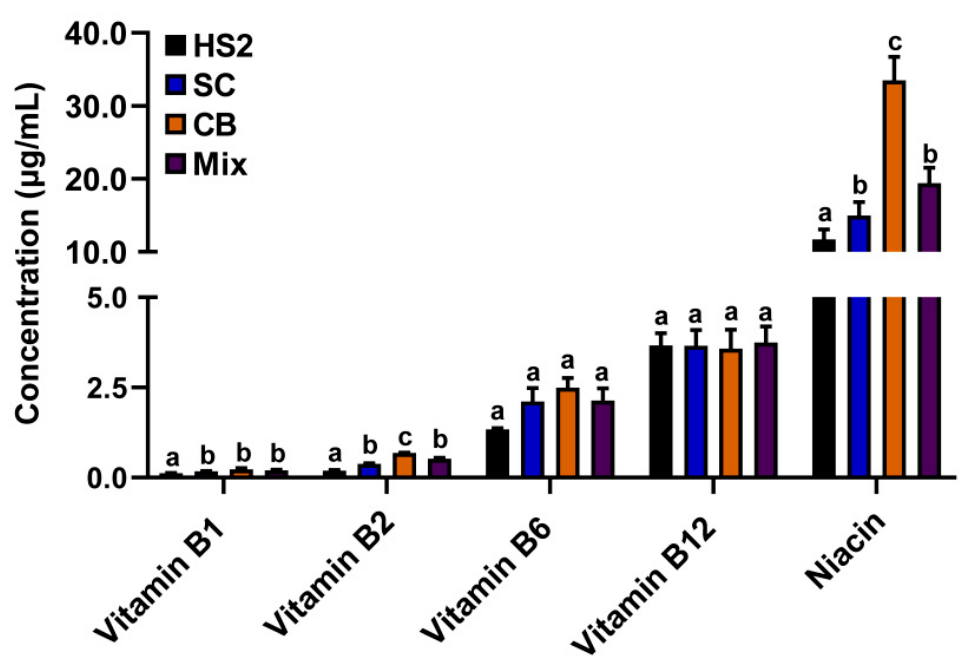
Figure 3. Vitamins B1, B2, B6, and niacin concentrations in rumen fluid of goats with CB, SC, and their combination supplementation. The different lower-letter indicated significantly different ( p < 0.05) and the same lower-letter indicated no significantly different ( p > 0.05) of the same B-vitamin.